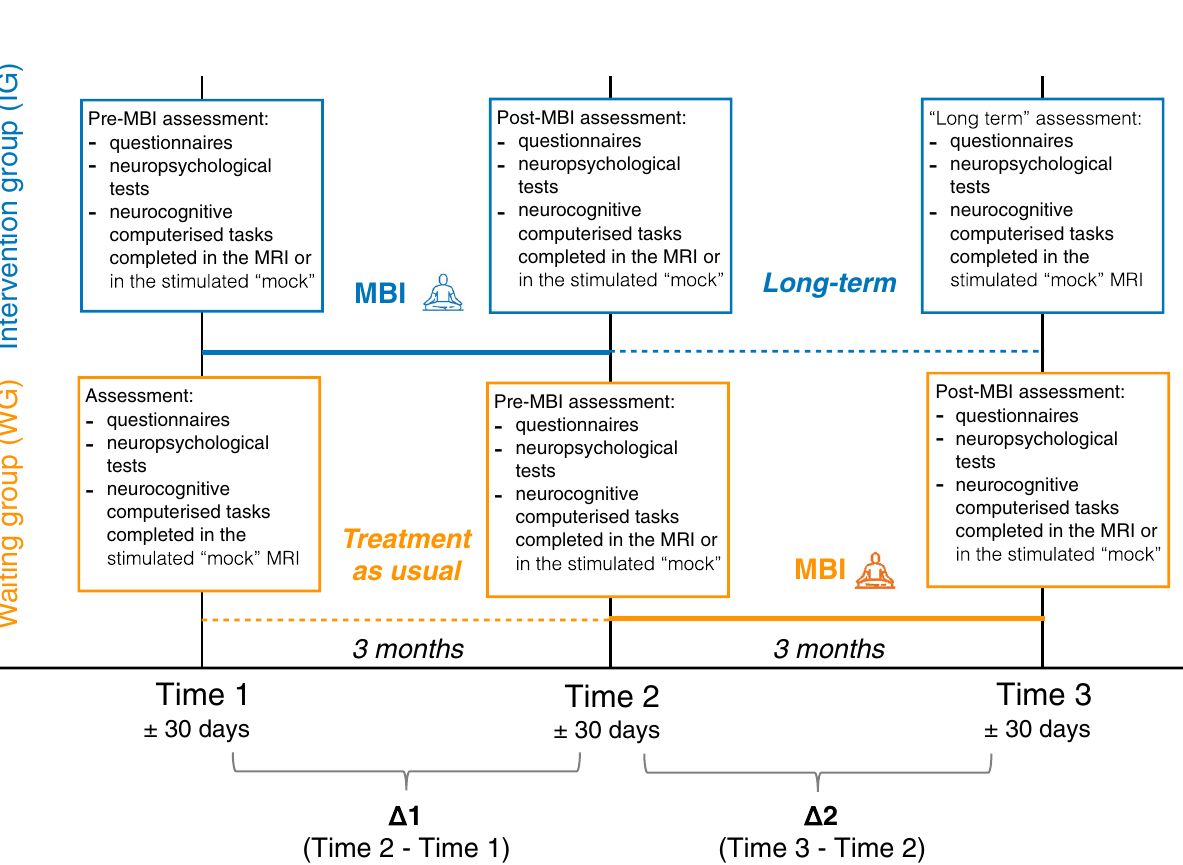
Figure 4. Illustration of the RCT study design. Participants enrolled in the RCT design were randomised in two groups: the intervention group (IG) in blue and the waiting group (WG) in